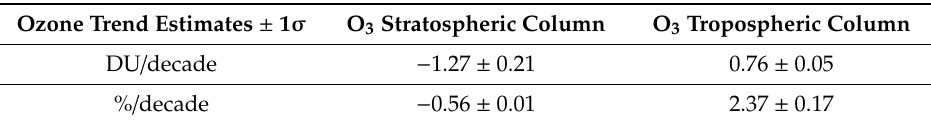
Table 3. Tropospheric and stratospheric ozone trend values as derived by the Trend-Run model at Irene